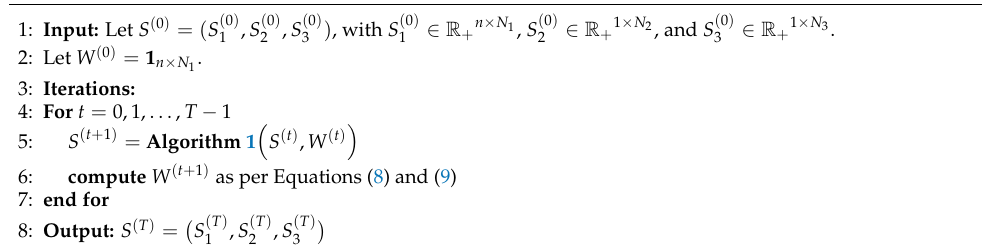
Algorithm 2 Reweighting